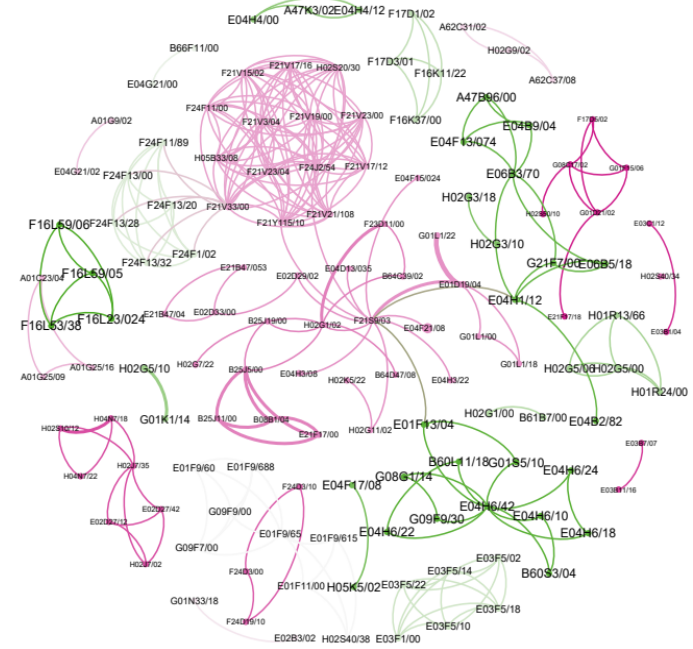
Figure 6. Digital construction innovation network (2016).